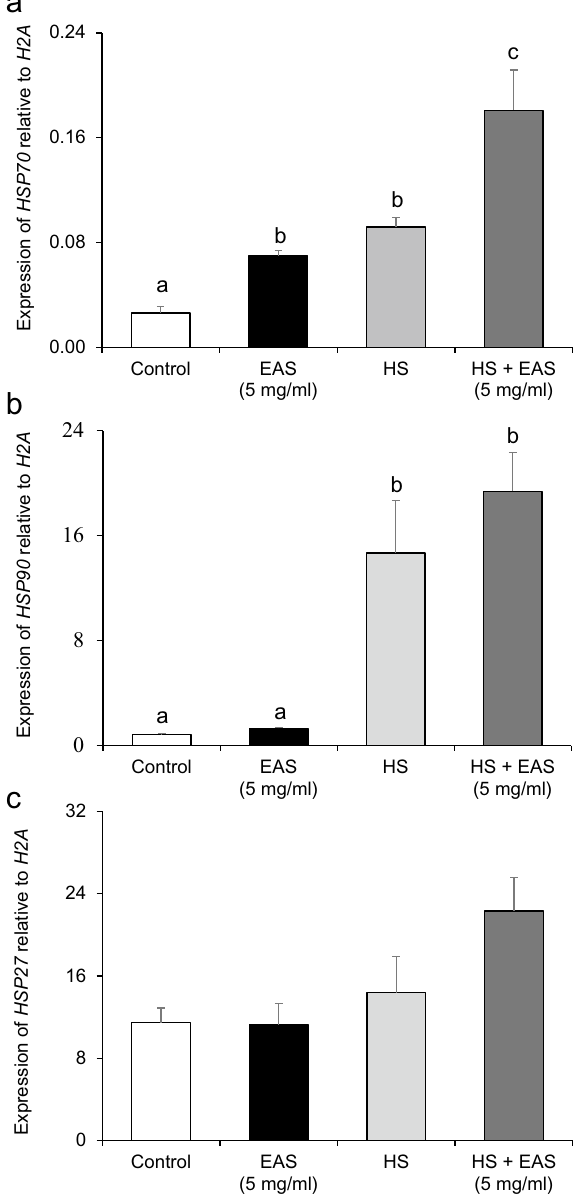
Figure 2. Effect of EAS on the expression of HSP70, HSP90 , and HSP27 in bovine CG cells under non- and HS conditions. Cells were treated for 6 h with or without EAS (5 mg/ml) under normal conditions at 38.5 °C (control, EAS group) and HS conditions at 41 °C (HS, HS + EAS group). ( a ) HSP70 , ( b ) HSP90 , and ( c ) HSP27 . Data are shown as the mean ± SEM, n = 5, a vs. b ( P < 0.05), a vs. c ( P < 0.01), and b vs. c ( P <